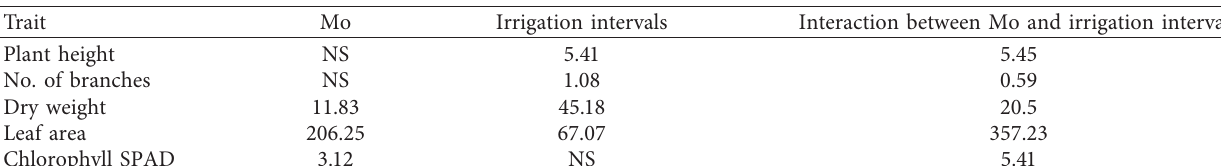
Table 1: Least significant differences (LSD) of the impact of molybdenum (Mo), irrigation intervals (I), and the interaction between Mo and I treatments on the growth